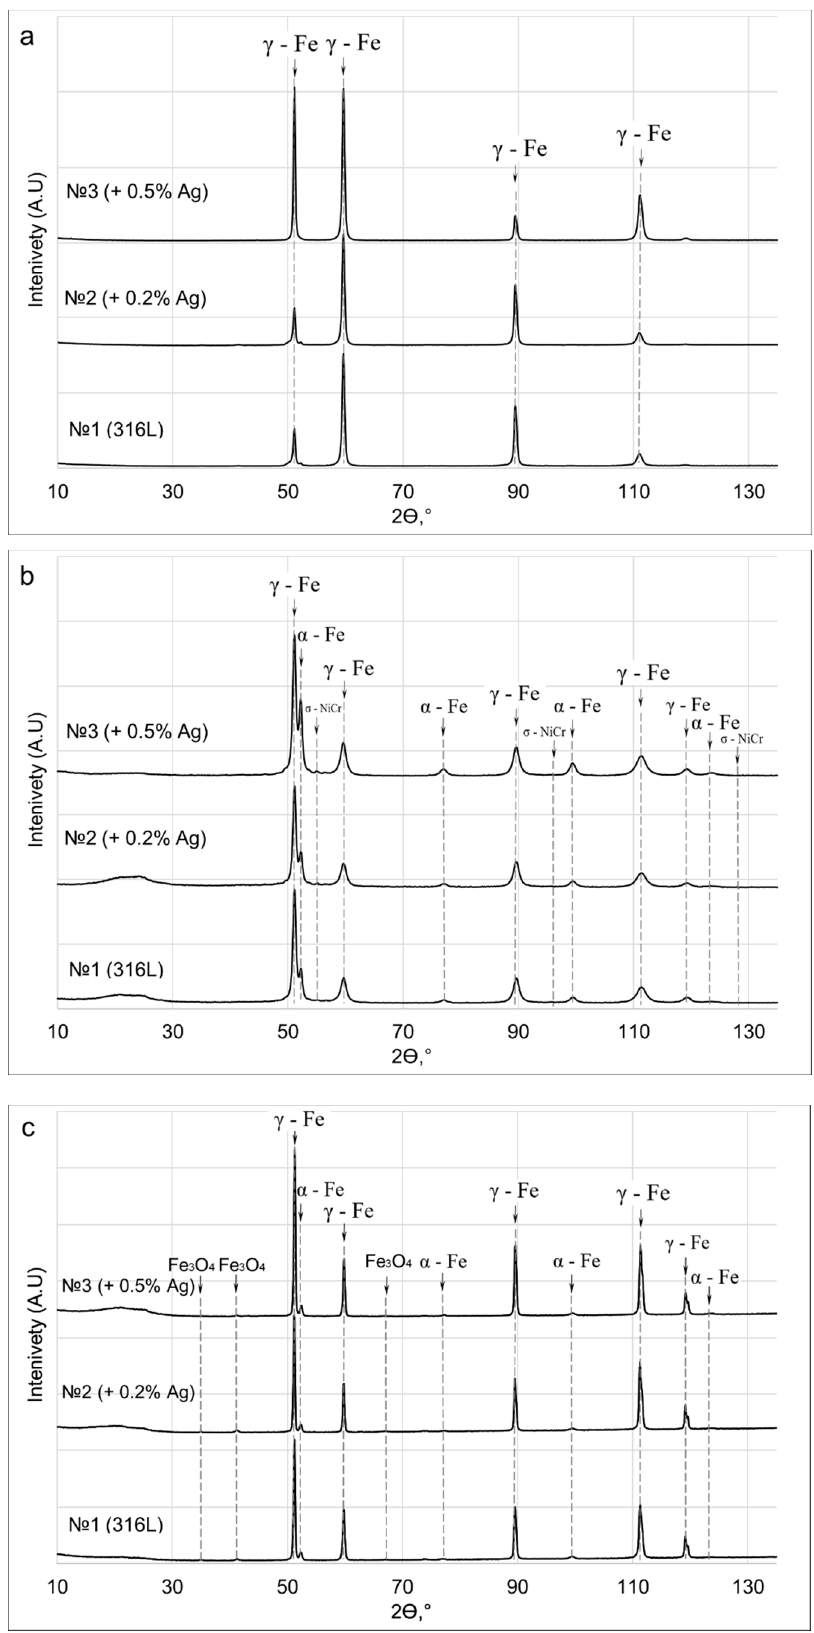
Figure 9. X-ray diffraction patterns of ingots ( a ), wire ( b ) and powder ( c ).